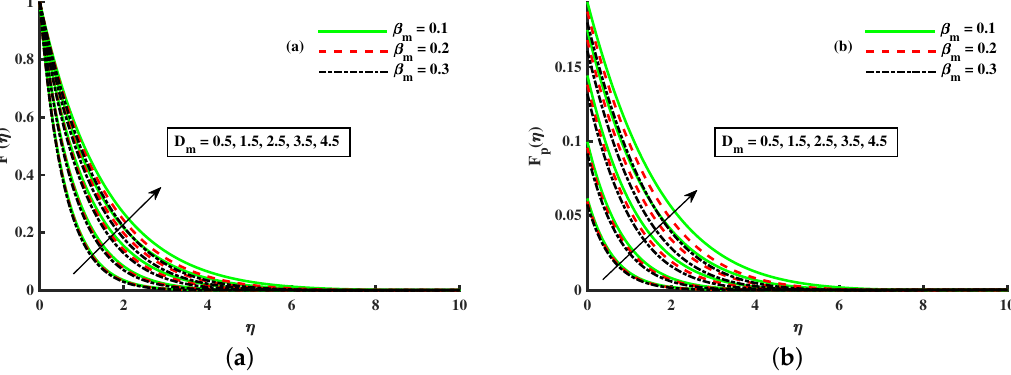
Figure 14. Fluctuation of β m and D m on F (cid:48) ( η ) ( a ) and the effect of β m and D m on F p ( η ) ( b